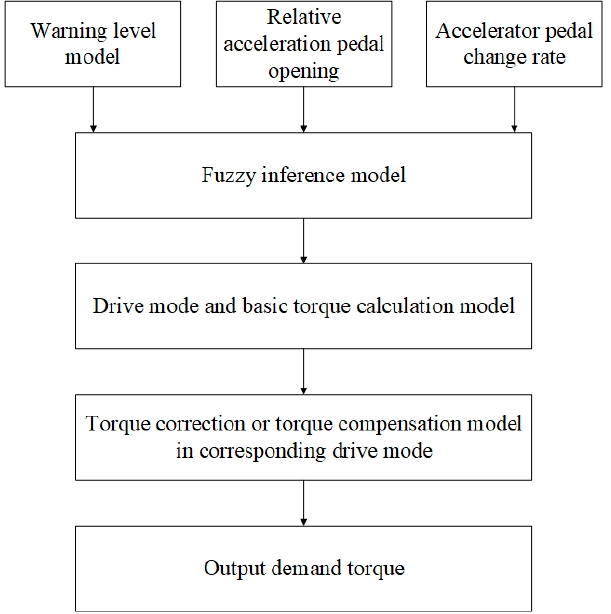
Figure 5. Drive control strategy